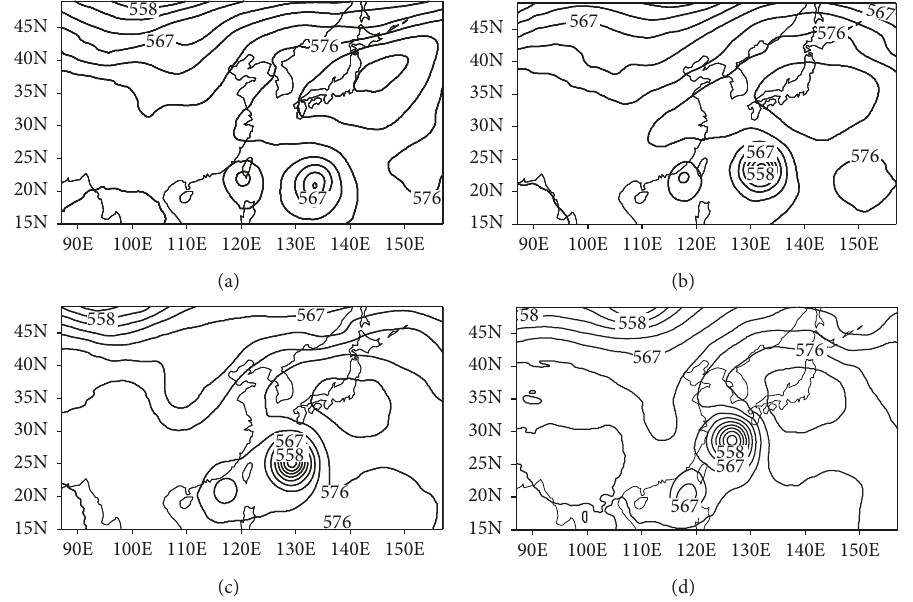
Figure 2: Geopotential height at 500hPa based on the ECMWF reanalysis data at 0000 UTC 24 August (a), 0000 UTC 25 August (b), 0000 UTC 26 August (c), and 0000 UTC 27 August (d) (intervals: 3-dagpm).